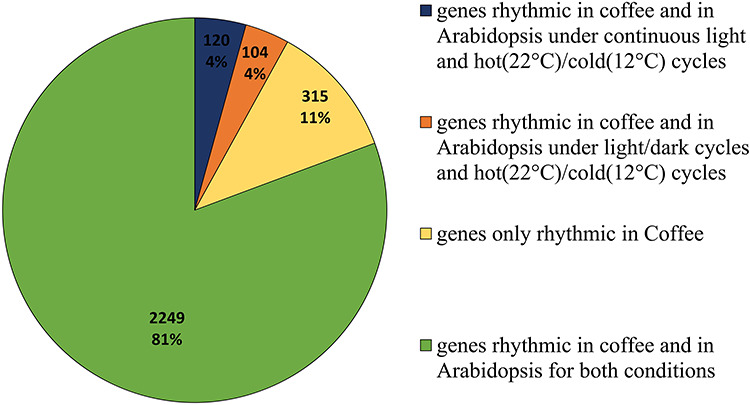
Rhythmic genes are common between coffee and Arabidopsis. We determined a list of rhythmic genes in coffee leaves with JTK-DESeq method. The number of rhythmic genes that have been described as rhythmic or circadian genes in Arabidopsis exposed to hot (22 °C)/cold (12 °C) cycles and continuous light conditions or to both light/dark cycles and to hot(22 °C)/cold (12 °C) conditions was determined. Here are the numbers of rhythmic genes in coffee in each of these conditions or in both of these conditions or the ones not common with these two conditions. Hot (22 °C)/cold (12 °C) cycles corresponds to ‘the average environmental changes across latitude and season for Arabidopsis in its natural habitat’. Arabidopsis circadian genes can be found on DIURNAL website (http://diurnal.mocklerlab.org/). We consider the genes correlated with a threshold of 50%. Lists are provided in Table S3 available as Supplementary Data at Tree Physiology Online.